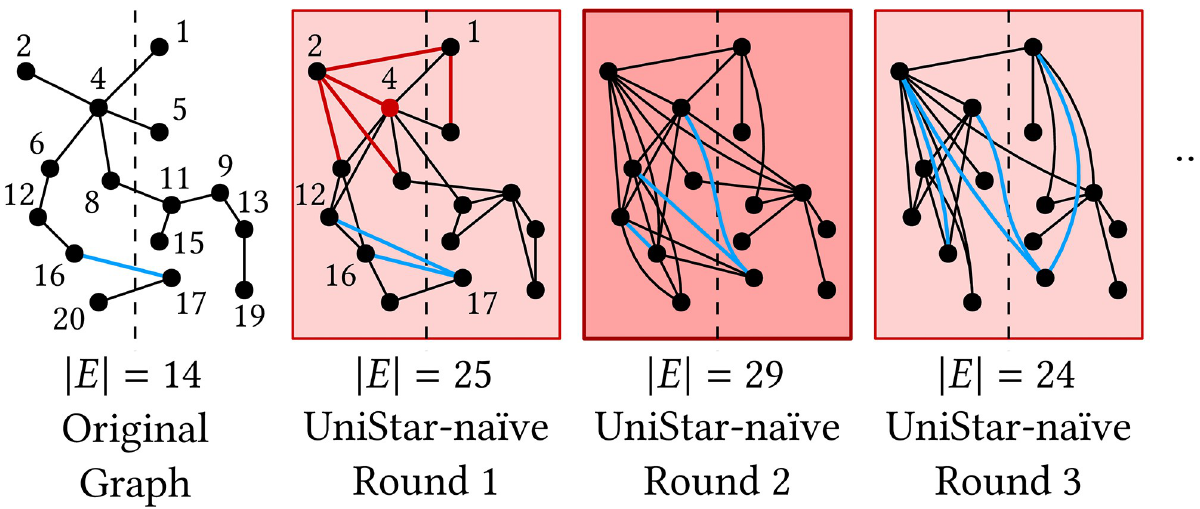
Fig 2. UniStar-na ï ve causes a data explosion problem. The more edges, the darker the background color in red. The blue lines show how edge (17, 16) propagates; the edge is copied every round. The dashed-line is the partition.